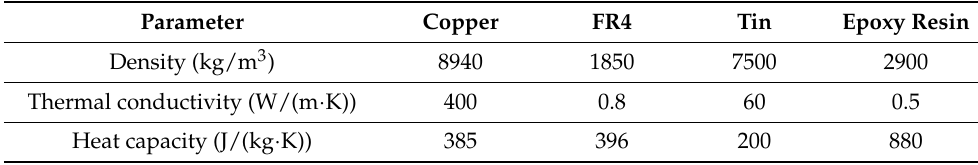
Table 4. The material properties used in the simulation model.